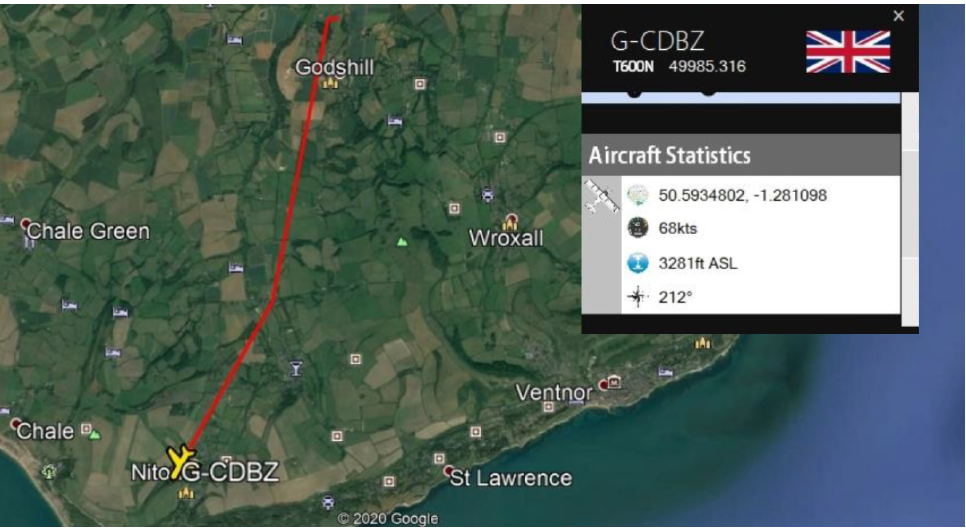
Figure 15. A follow up from the previous image, the window can be scrolled on to show more information, which is live updated as the transmissions are